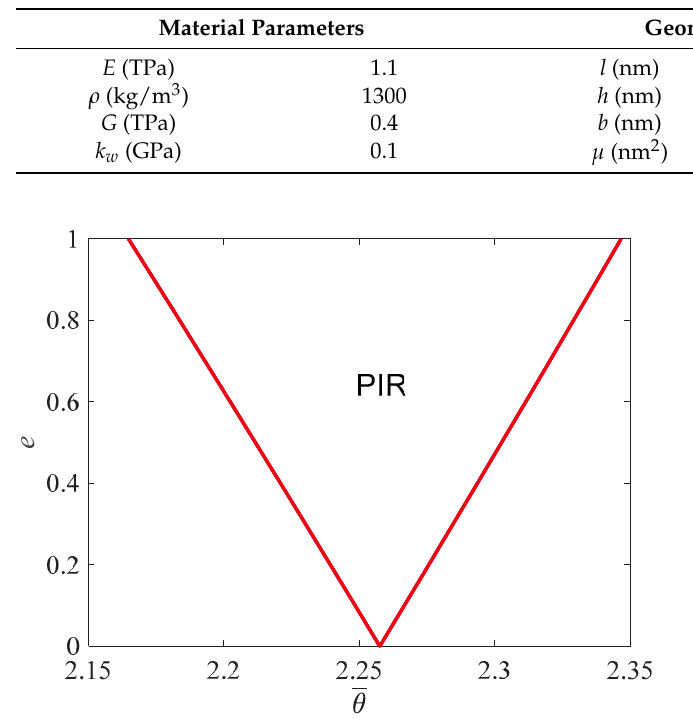
Table 1. Parameters of the studied nanobeam.